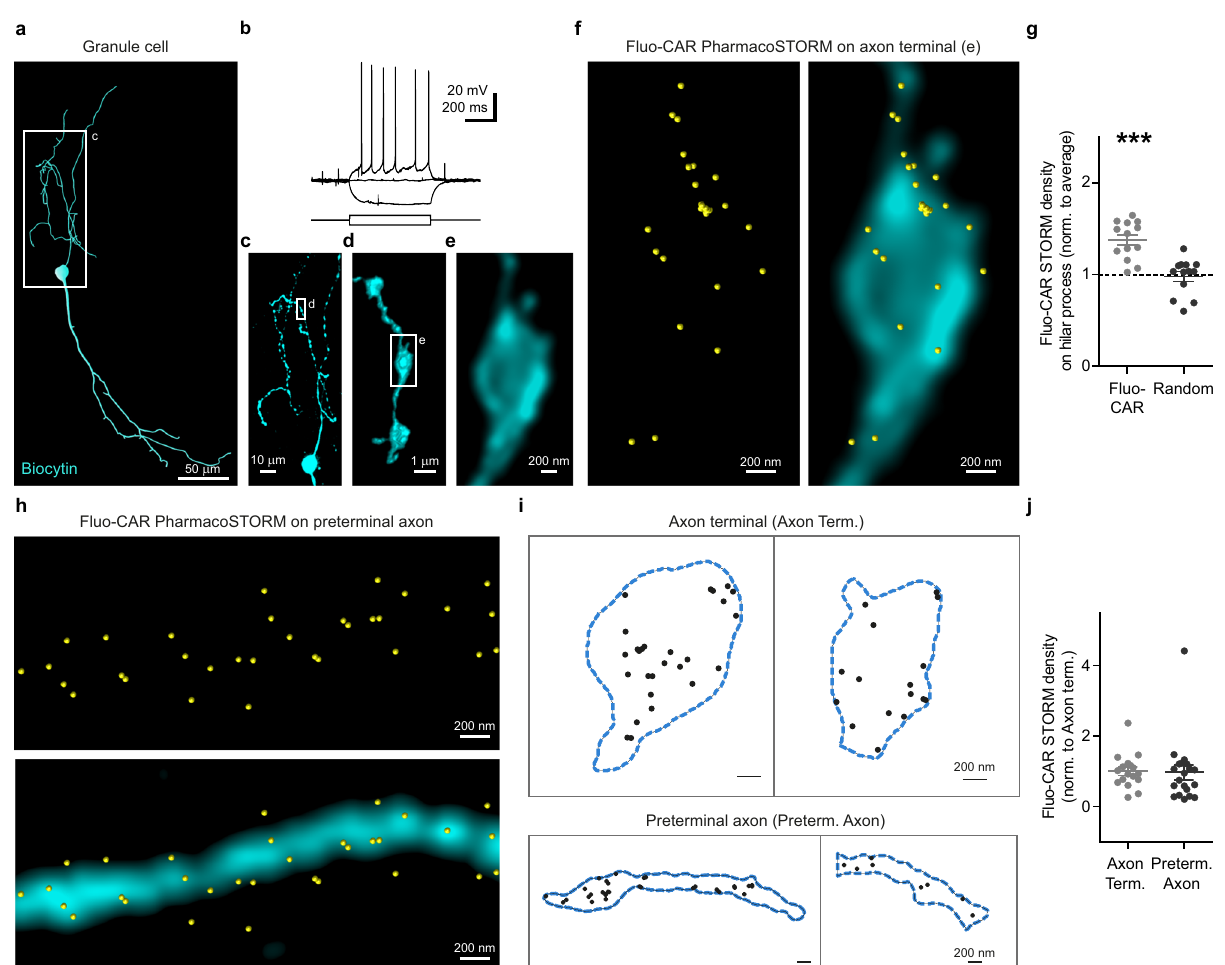
Fig. 7 Cell-type- and subcellular compartment-speci fi c nanoscale distribution of fl uo-cariprazine binding on the axons of the granule cells in the Islands of Calleja. a – f Combination of nanoscale molecular imaging of Fluo-CAR-binding sites with cellular anatomical and electrophysiological characterization. a Neurolucida reconstruction of a representative biocytin- fi lled granule cell in the Islands of Calleja. b Voltage traces in response to + 7 pA, 0 pA, − 10 pA current steps from resting membrane potential recorded in whole-cell current-clamp con fi guration reveal the action potential fi ring pattern of the same granule cell shown in ( a ). c Maximum intensity z -projection of the confocal image stack of the hilar process in the boxed area in ( a ). d Volume view of a high-resolution confocal image stack taken from a varicose segment from boxed area in ( c ). e Higher magni fi cation deconvolved confocal image of the boxed area in ( d ) illustrates a single axon terminal of the granule cell. f Correlated confocal and PharmacoSTORM imaging of the granule cell bouton (cyan) presented in ( e ), and the corresponding Fluo-CAR-binding sites (yellow) along the surface of the axon terminal. g Scatter dot plot shows the LP density on granule cell axons normalized to the average LP density on the same image. Two-tailed Wilcoxon signed-rank test shows that Fluo-CAR density on the axon of biocytin- fi lled cells is signi fi cantly higher than expected from random distribution ( n = 13, n = 6 animals, P = 0.0002; P = 0.8394 for randomly distributed LPs). h Correlated confocal and PharmacoSTORM image of Fluo-CAR binding sites (yellow) on a long preterminal segment of a granule cell axon (cyan). i Schematic illustration of representative segmented PharmacoSTORM images for further analysis. Contours of axon terminals and preterminal axon segments are shown as blue dashed lines. Fluo-CAR LPs are represented as black dots. j Comparative analysis of nanoscale Fluo- CAR-binding site density on the distinct axonal subcompartments. Values are normalized to the mean density on axon terminals. Two-tailed Mann – Whitney test revealed no signi fi cant difference of Fluo-CAR-binding site density between the two subcellular compartments (axon terminals: n = 17, preterminal axon segments: n = 20, P =